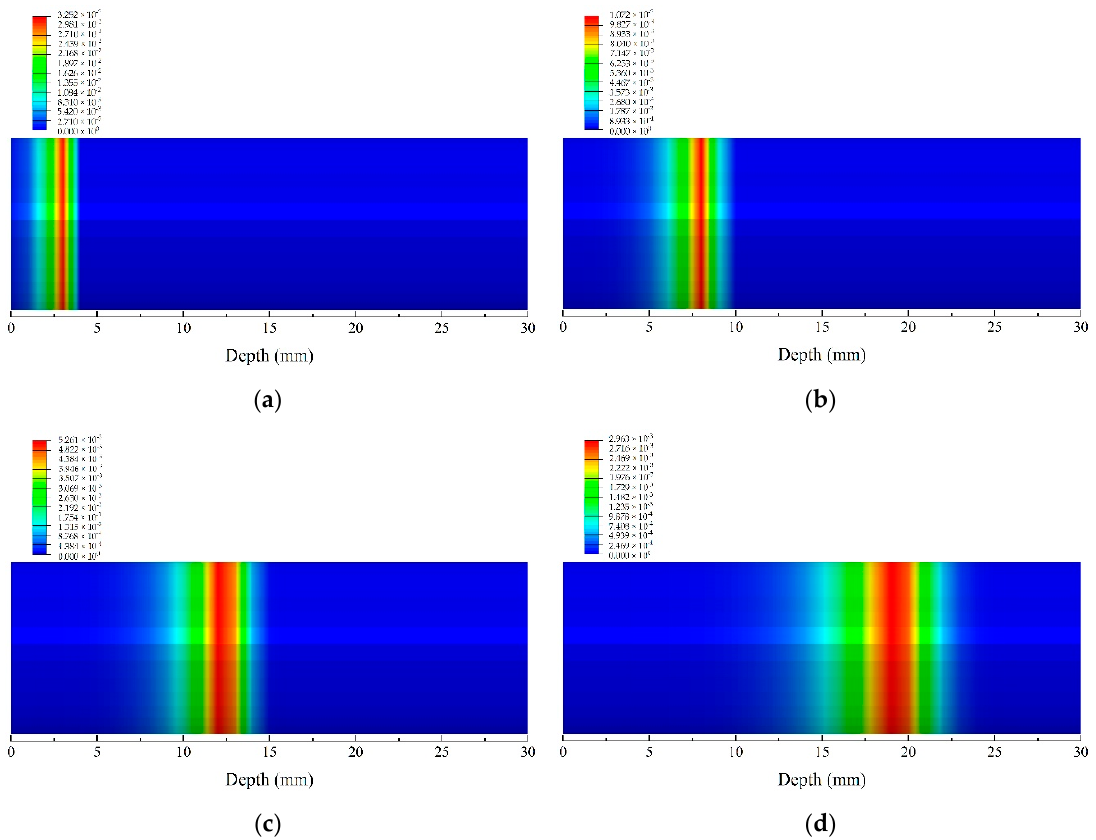
Figure 10. Decomposition rate contours of the glass fiber/phenolic resin composites specimen at different times under one-sided heating. ( a ) 50 s ( b ); 200 s; ( c ) 400 s; ( d ) 800 s.